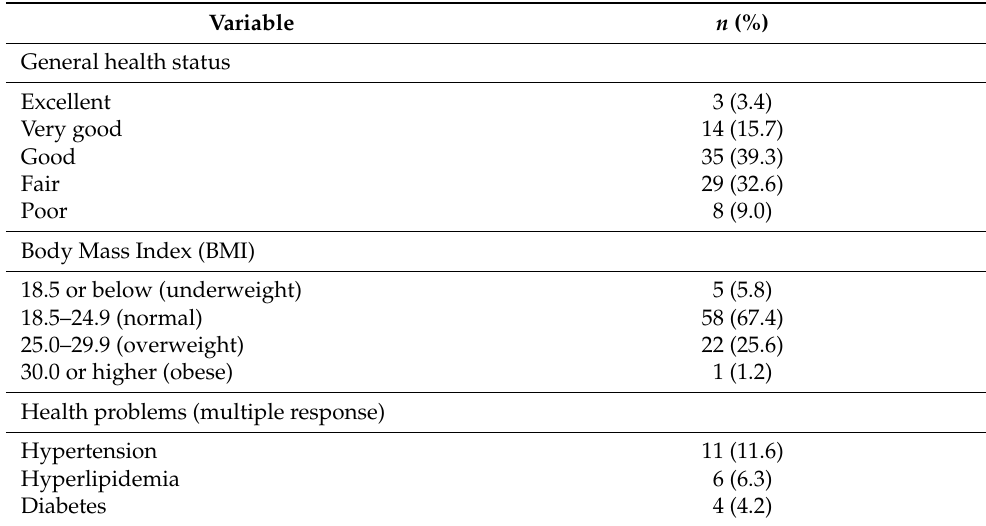
Table 3. Health status of Korean workers ( n = 95).